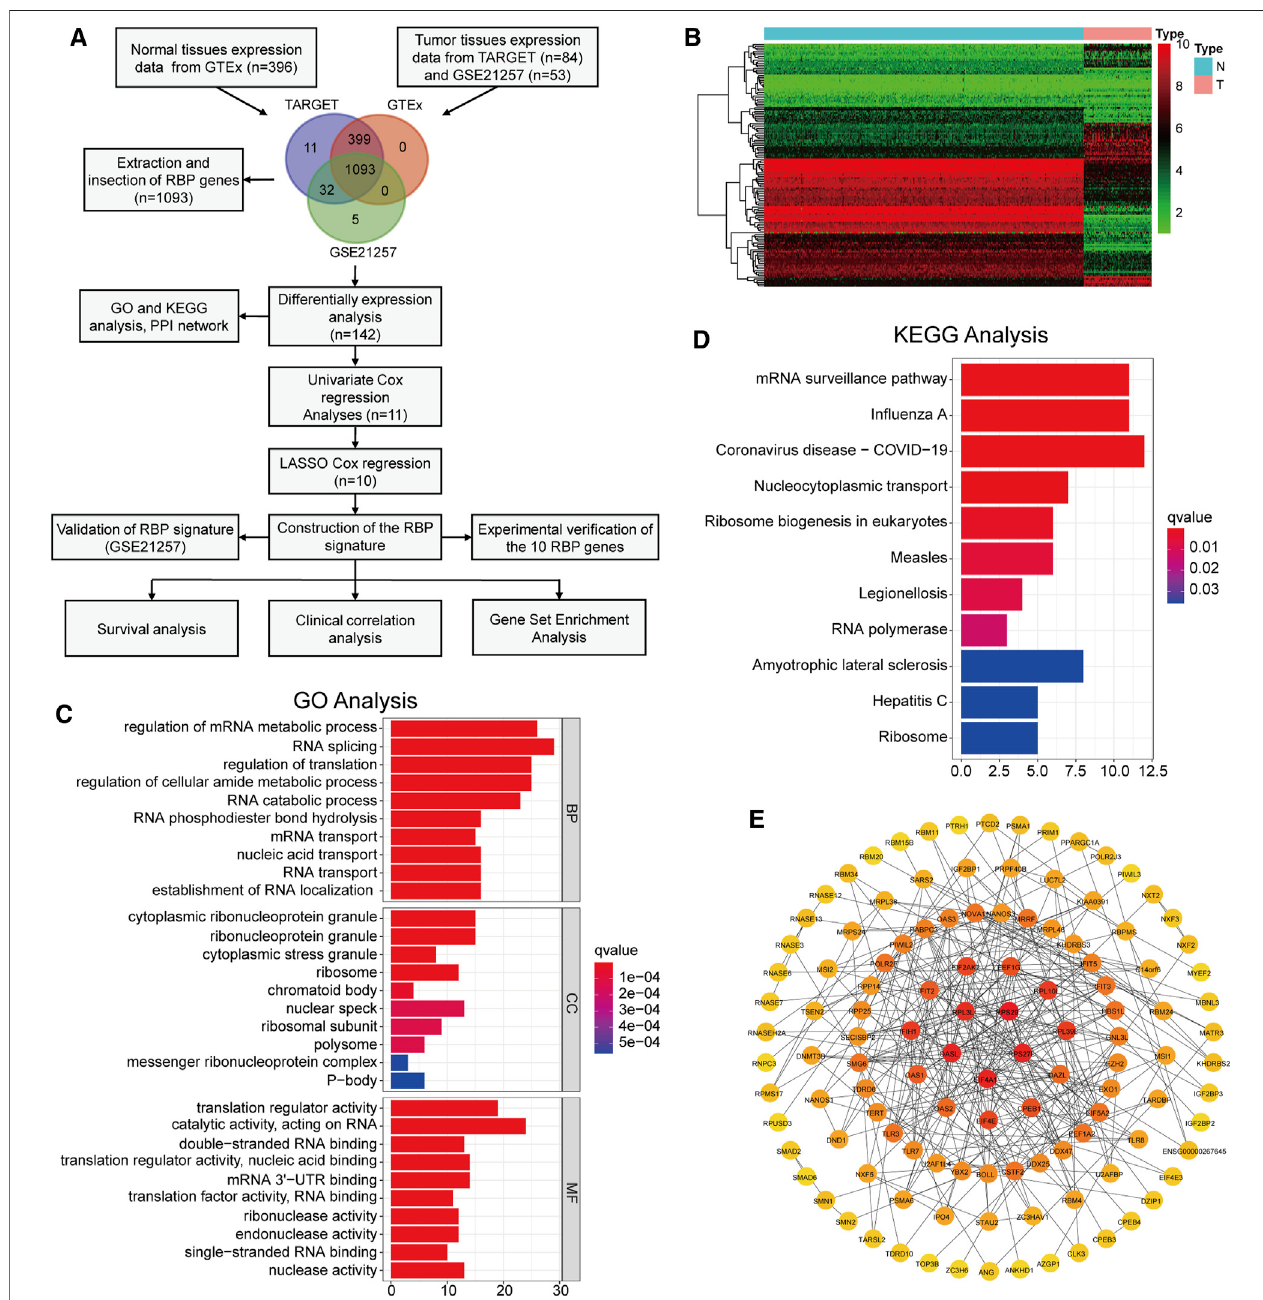
FIGURE 1 | Identi fi cation of differentially expressed RBPs and functional analysis (A) The fl ow chart of this study (B) The heatmap of 142 differentially expressed RBPs (C,D) GO analysis and KEGG pathway analysis of the differentially expressed RBPs (E) PPI network diagram composed of differentially expressed RBPs.